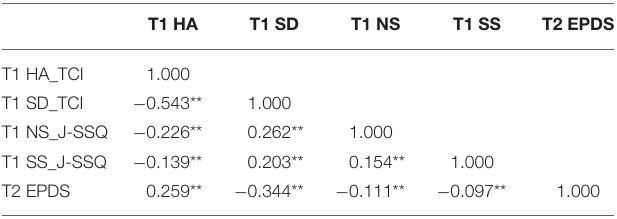
TABLE 2 | Correlations between